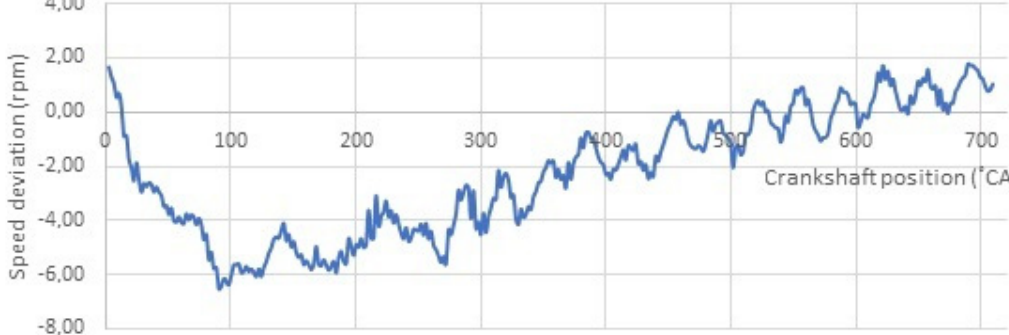
Figure 6. The waveform of instantaneous angular velocity deviation of the engine Buckau-Wolf R8DV-136 for a pre-set speed of 190 rpm with no combustion in cylinder 1.